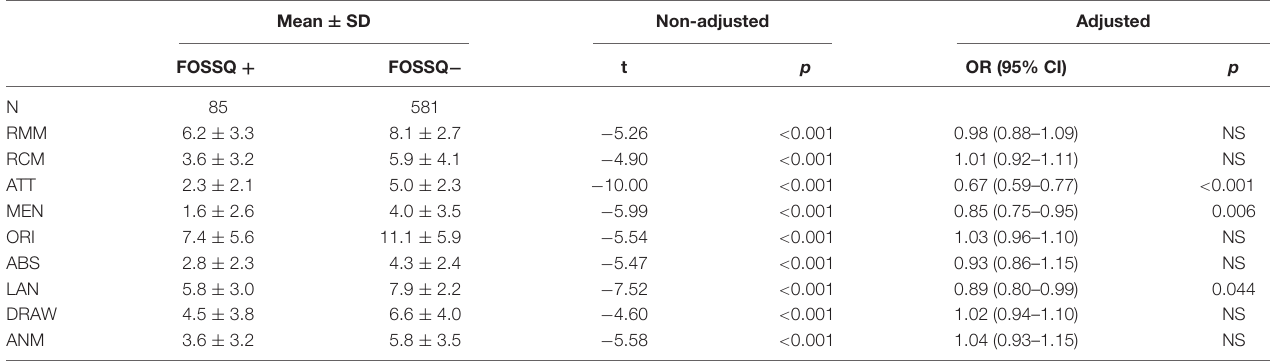
TABLE 3 | Comparison of each cognitive domain in CASI between groups with FOSSQ + and FOSSQ – adjusted for age, education, gender, and disease severity according to CDR. Mean ± SD Non-adjusted Adjusted FOSSQ + FOSSQ −